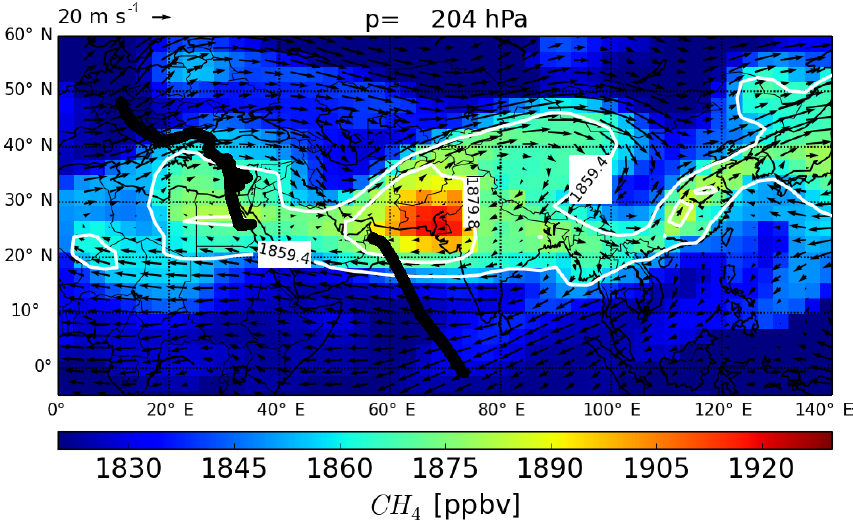
Figure 16. Double anticyclone mode illustrated with wind field and CH 4 EMAC daily means at 204hPa (25 July 2015) and the associated flight tracks. White contours represent the CH 4 threshold and background values according to Sect. 3.1.